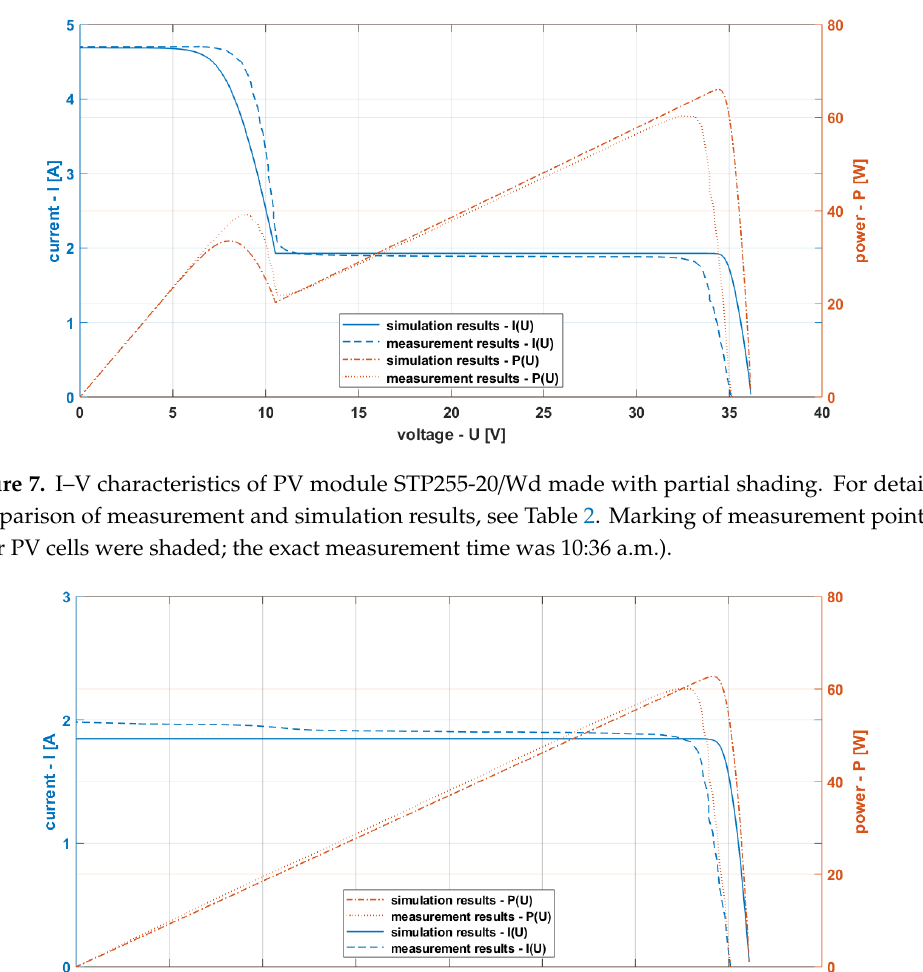
Figure 6. I–V characteristics of PV module STP255-20/Wd made with partial shading. For detailed comparison of measurement and simulation results, see Table 2. Marking of measurement point P1 (two PV cells were shaded; the exact measurement time was 10:24 a.m..